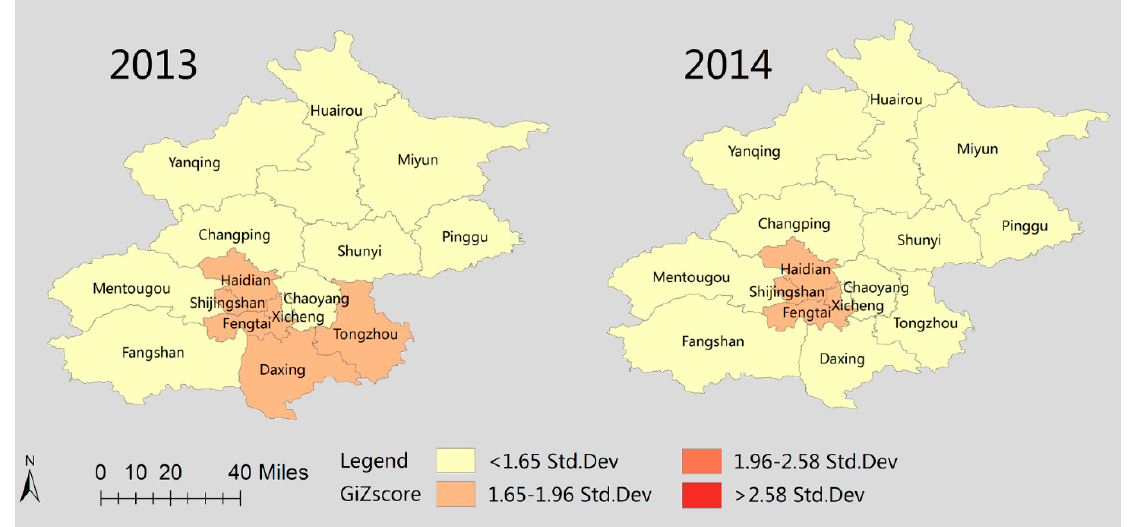
Figure 3. Hotspot clusters of scarlet fever incidence in Beijing, 2005–2014.